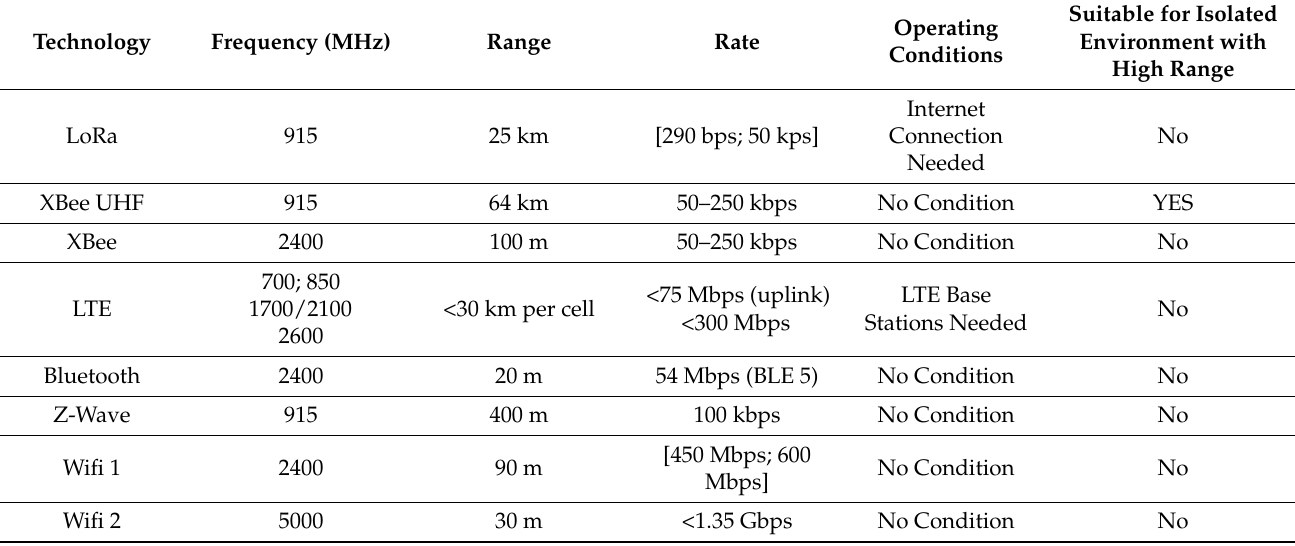
Table 1. Comparison of the different wireless